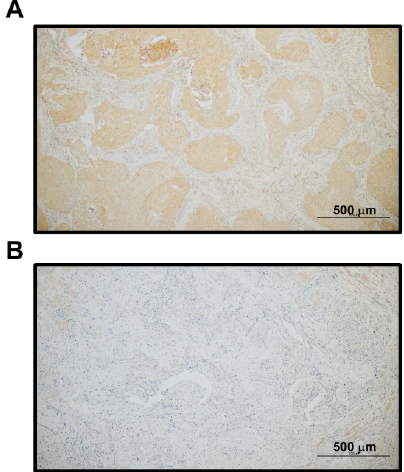
Figure 1. Immunohistochemical staining of LIF expression in patients with OSCC. LIF expression was